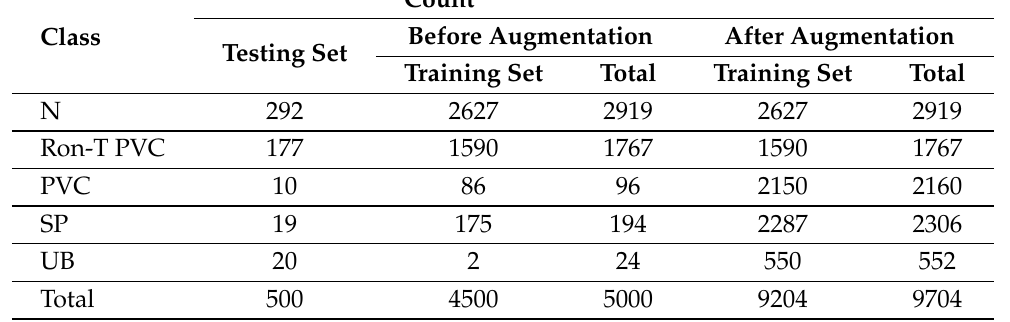
Table 3. Distribution of samples of ECG5000 dataset in Experiments 1–10 of Table 1, before and after data augmentation.